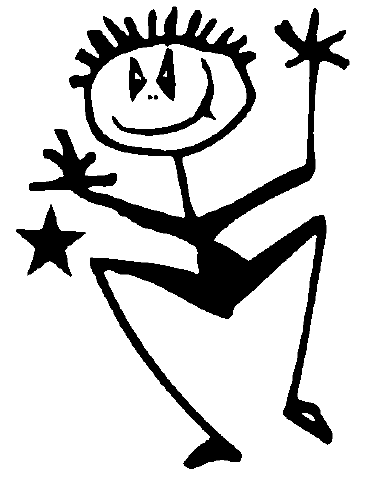
Figure 1: The Crew Man - Logo,